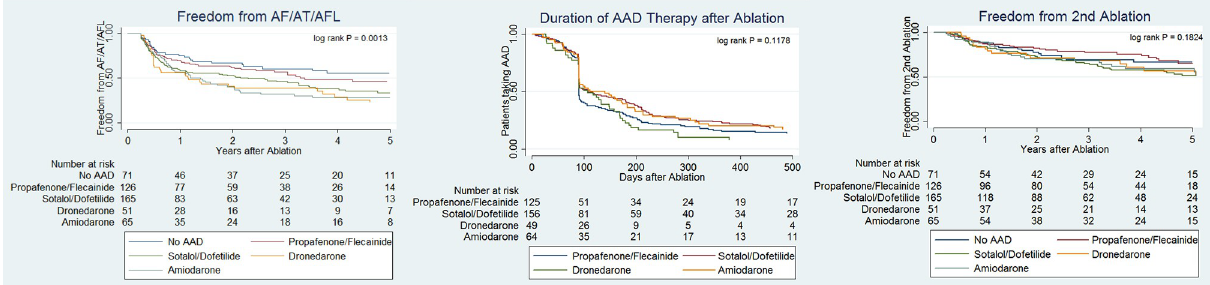
Fig 2. Kaplan-Meier plots of A) recurrence of atrial arrhythmias (excluding a 3-month post-procedural blanking period) on or off AAD; B) time to initial discontinuation of AAD; C) time to second ablation procedure (excluding a 3-month post-procedural blanking period).